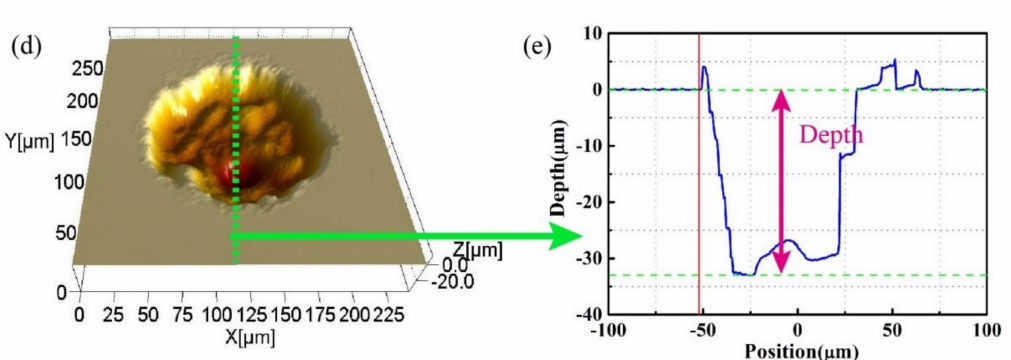
Figure 2. Geometrical parameters and distribution of textured plates: ( a – c ) SEM images of the three different textured samples; ( d ) 3D image of a single dimple; and ( e ) cross-section profiles of a single dimple.